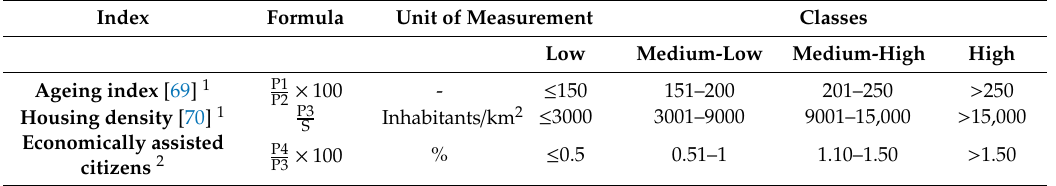
Table 1. Applied formulas and classes’ subdivision for socio-demographic analyses at the neighborhood scale.